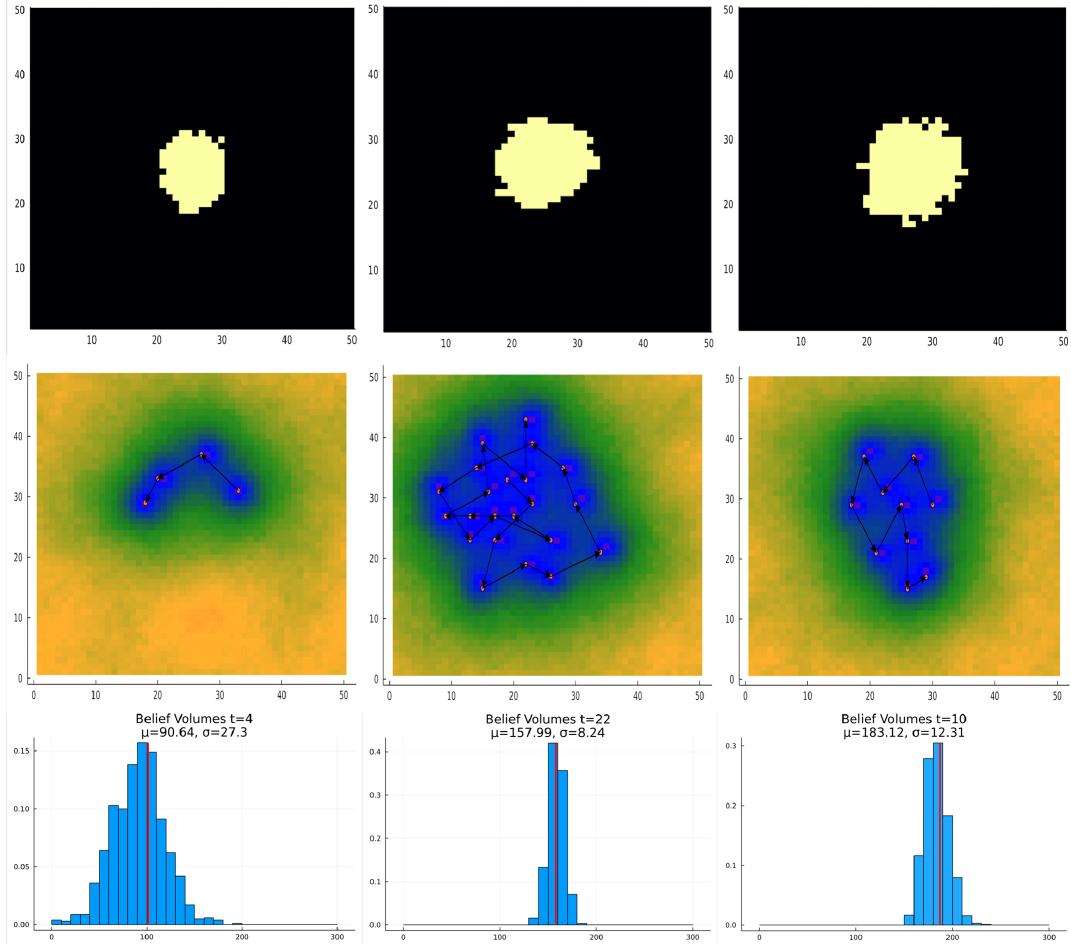
Figure 29. Deposit size study results for the case of a single body with fixed centroid location. The sub-economic, borderline, and economic cases are shown in the left, center, and right columns, respectively. The top row shows the massive ore present in the tested case. The center row shows the trajectory taken by POMCPOW and the standard deviation of the resultant belief. The bottom row shows the histogram of the ore volumes in the final belief along with the true massive ore